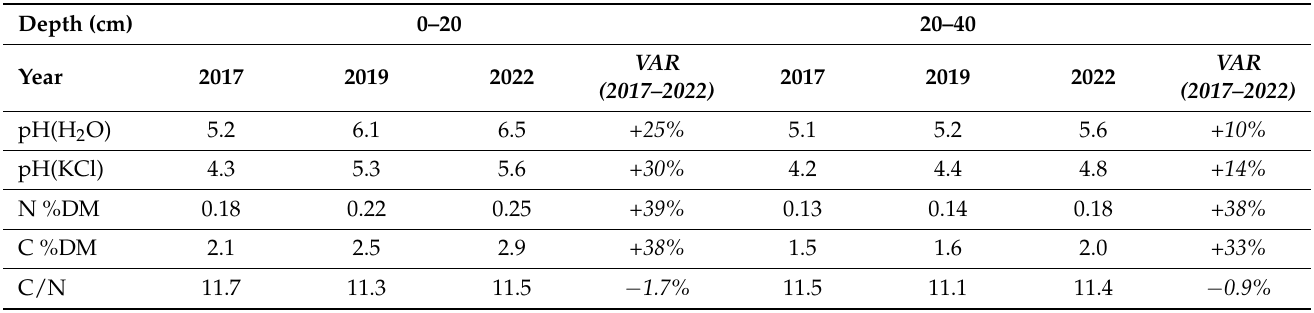
Table 2. Results of the three first soil analyses at 0–20 cm and 20–40 cm for the pH (H 2 O), pH (KCl), total soil organic nitrogen (N) and organic carbon (C), and C/N